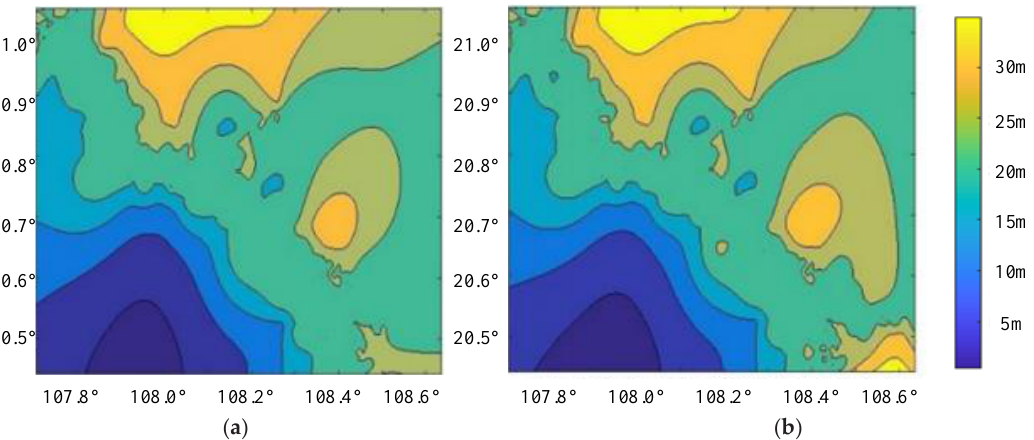
Figure 9. Comparison of the results of prediction of waterway depth for Fangcheng Port: ( a ) ground truth data, ( b ) predicted waterway depth.